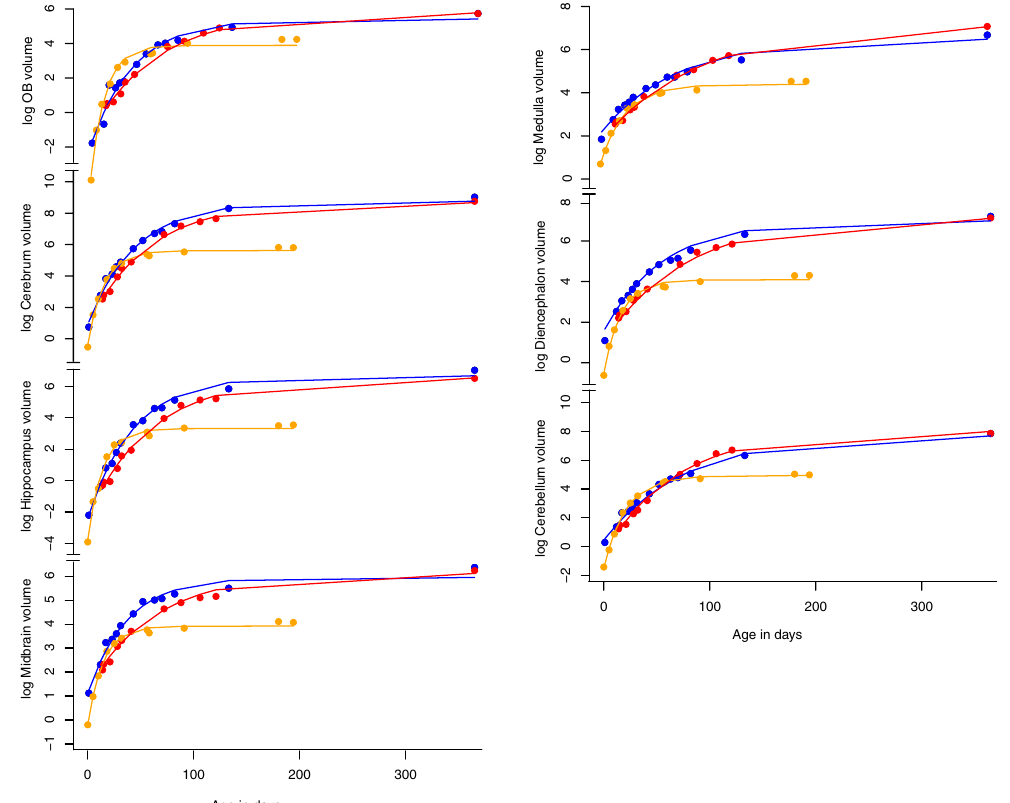
Figure 5. Plots of log partition volume growth (in mm 3 ) against specimen age, with curves fitted as described in Materials and